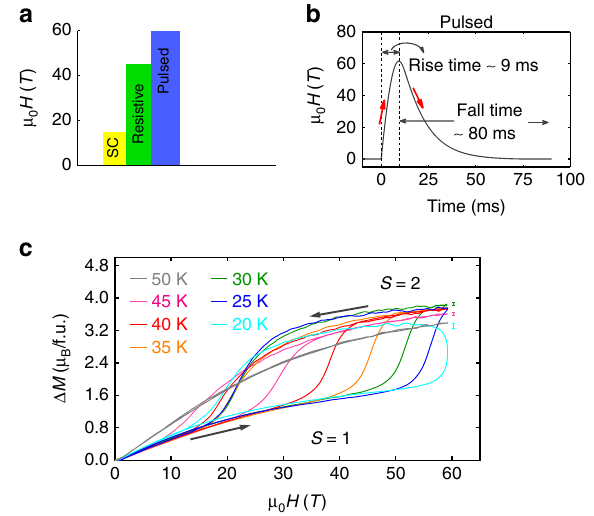
Fig. 2 SST in Mn(taa) as a function of pulsed magnetic fi eld. a Magnetic fi eld range of the magnets used in this work: superconducting (up to 14T), resistive DC (up to 45T), and pulsed (up to 60T). b The magnetic fi eld vs time for the pulsed magnet. c Δ M relative to M ( H = 0) as a function of H up to 60 T for different T on a randomly oriented collection of single crystals. Data is taken after zero fi eld cooling (electric and magnetic fi elds) from room temperature. The SST is evident as a broad jump in the magnetization. For a given temperature, the jump in SST occurs at a higher H for the upsweep than the downsweep. The standard errors due to random noise are smaller than the line widths. A systemic error due to mechanical vibrations yields oscillations, and their maximum amplitude is indicated by an error bars in the plot